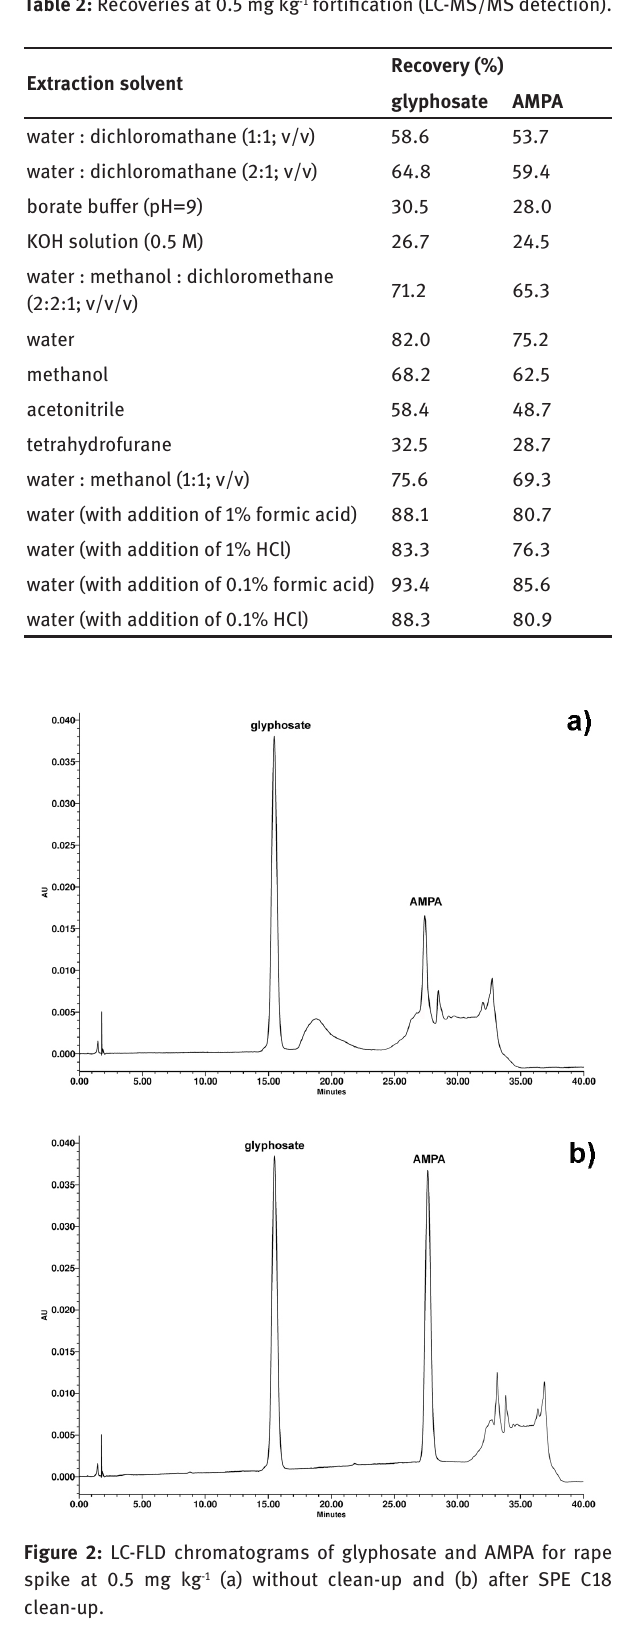
Table 2: Recoveries at 0.5 mg kg -1 fortification (LC-MS/MS detection).